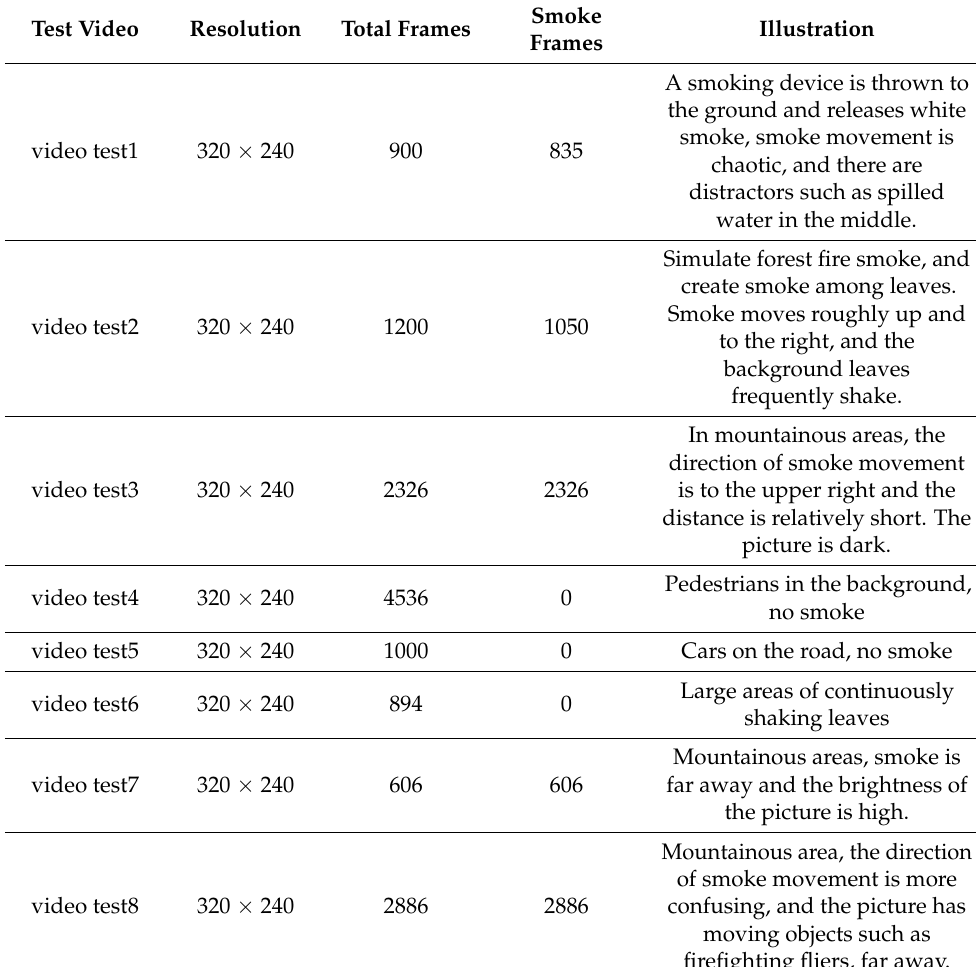
Table 2. Test video description.